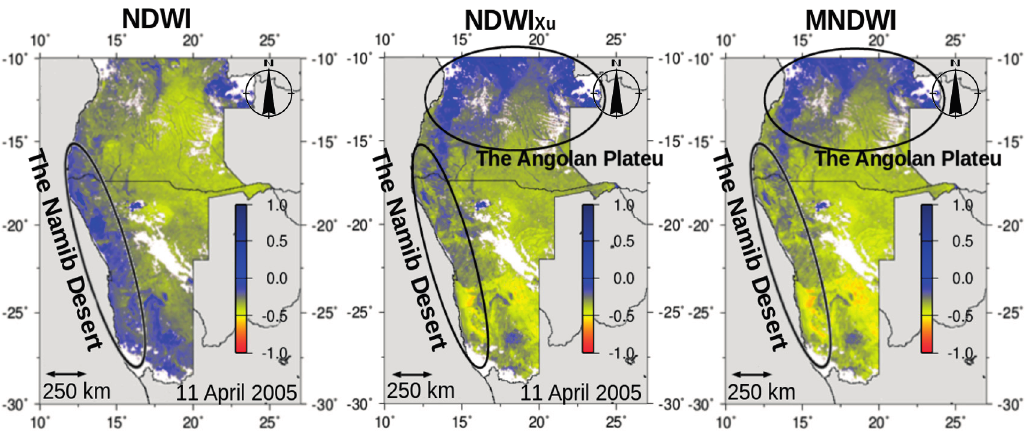
Figure 3. Comparison among ( Left ) Takeuchi’s NDWI value based on data from the red value based on data from the green and SWIR and SWIR bands, ( Center ) Xu’s NDWI Xu bands, and ( Right ) MNDWI from the present study based on the MODIS data from the red, green, blue, and SWIR bands. NDWI is biased by the widespread red soils that occur in the is biased by the abundance of study area (particularly in the Namib Desert), whereas NDWI Xu green vegetation (particularly in the Angolan Plateau); MNDWI corrects for these problems. The white areas represent pixels eliminated from the map due to cloud